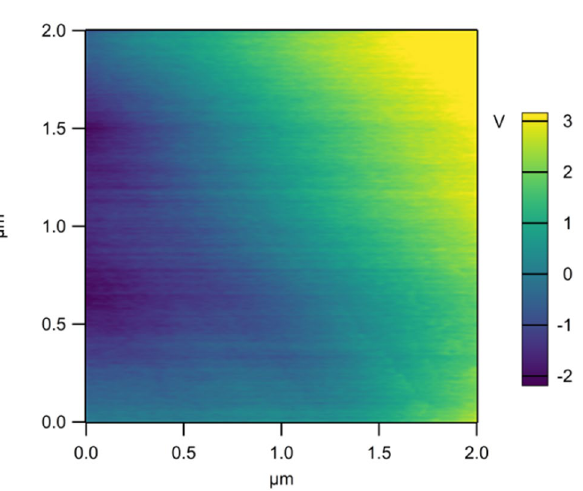
Figure 6. Surface charge density distribution of MNF treated by triboelectric